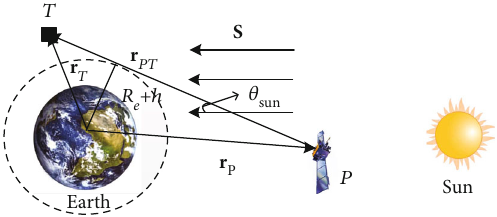
Figure 2: The constraint of Earth occultation and sun illumination.